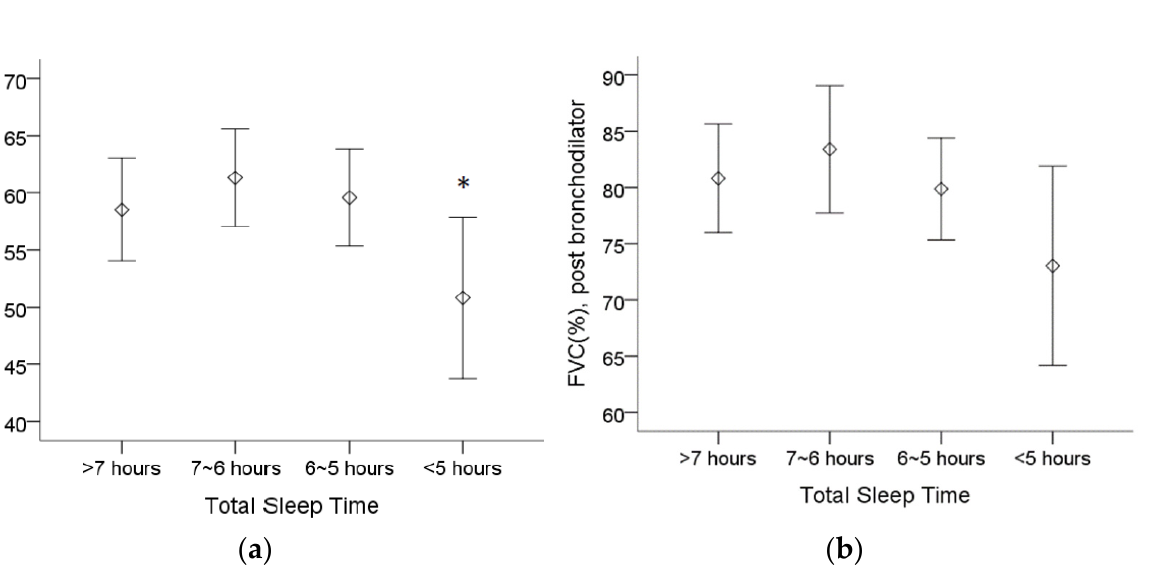
Figure 1. The assessment of pulmonary function in 4 different total sleep time groups from spirometry. ( a ) The post bronchodilator predicted forced expiratory volume in 1 s (FEV 1 (%)) was lower in patients who sleep less than 5 h than in patients who sleep between 6 and 7 h. ( b ) The trend of lower forced vital capacity (FVC (%)) appeared in patients who sleep less than 5 h, although no statistical significance was found. Note: 95% confidence interval, *: p < 0.05 vs. 6~7 h. Abbreviations: FEV 1 = forced expiratory volume in one second, FVC = forced vital capacity. For GOLD criteria, there was a significant higher total sleep time in GOLD group B compared to GOLD group A (Figure 2a). If we divided those patients into fewer symptoms (group A and C) or more symptoms (group B and D), there was a significant higher total sleep time in COPD patients with more symptoms (Figure 2c). However, there was no significant difference in total sleep time among low-risk patients (group A and B) compared to high-risk patients (group C and D) (Figure